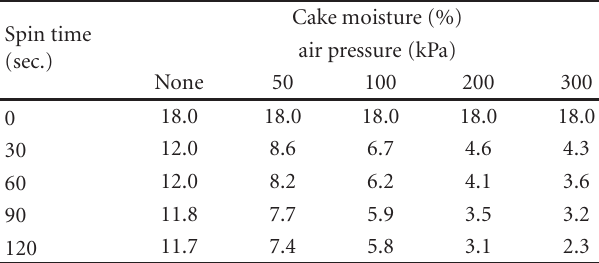
Table 9: E ff ects of G -force and air pressure on the dewatering